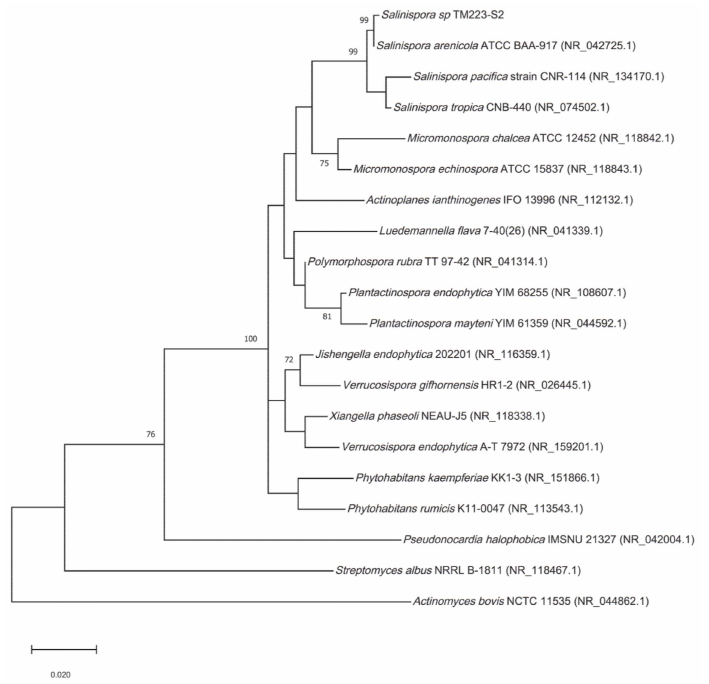
Figure 1. Phylogenic tree. Maximum-likelihood tree obtained from 16S rRNA sequence alignment of the isolate TM223-S2 and representatives of the three Salinispora spp. described, together with relatives from Actinomycetales. Only bootstrap values greater than 70% are reported (1000 replicates). Genbank accessions are mentioned in